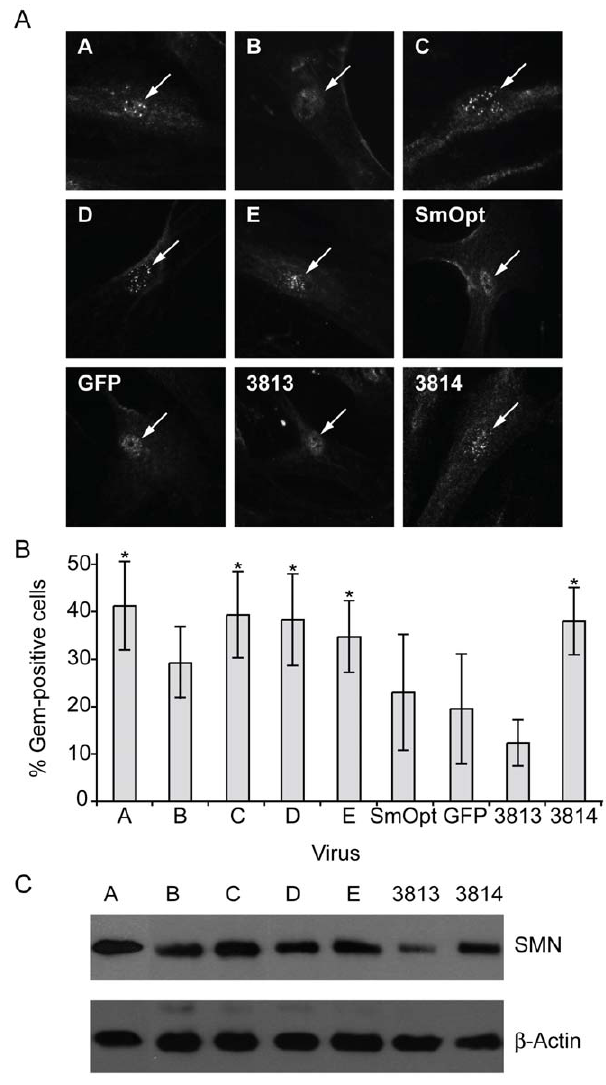
Figure 4. Determination of changes in functional protein levels following Adv-5/antisense U7 snRNA infection. (A) SMA type-I fibroblast cells (G3813) were transduced with Adv-5 vectors either expressing antisense U7 snRNAs or control vectors expressing SmOpt or GFP. The cell cultures were passaged for 10 days in 2% FBS medium, fixed with formaldehyde, and analyzed using immunofluorescence. As an indicator for SMN levels the fraction of nuclear gem-positive cells was determined by fluores- cence microscopy. Cell nuclei are marked with white arrows. The identity of the Adv-5 vectors is indicated on the left upper corner of each panel. (B) The bar graph summarizes gem counts from 5 independent and blinded experiments. Standard deviations are shown for each series. An asterisk above bars indicates a statistically significant difference between the experimental series and the SmOpt control series. A statistically significant difference between series is defined by p-values , 0.05. (C) Western blot analysis of cell cultures infected with AdV5/U7 antisense snRNPs. G3813 cells were transduced with AdV5/antisense U7 snRNPs at an MOI of 20. The expression levels were normalized to b -Actin using an anti b -Actin monoclonal antibody. Relative SMN protein levels were determined by SMN staining using a monoclonal anti SMN